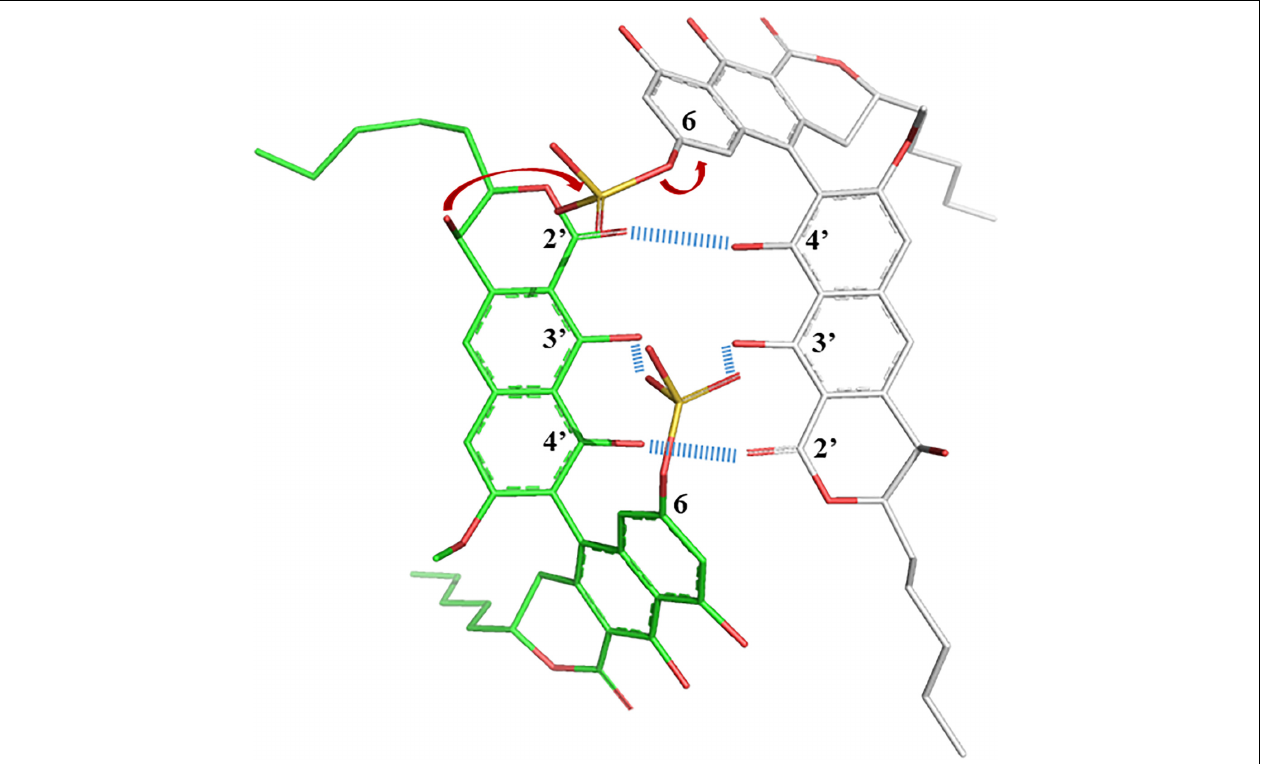
FIGURE 5 | Crude sculpted and minimized structural model of 1 displaying the sulfate potential role in stabilizing oligomerization, as well as the possibility to intermolecularly react specifically at the C-9’ position to form 2 under acidic conditions.